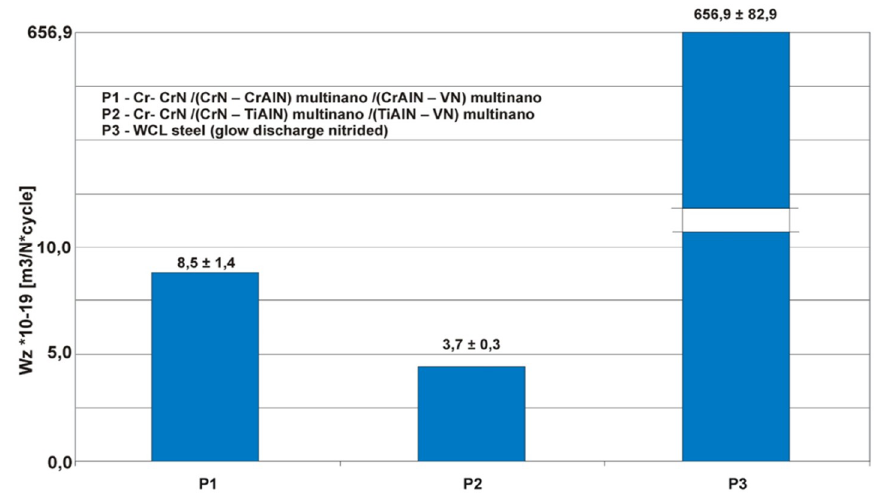
Figure 9. Wear resistance of P1, P2 multilayer coatings and reference nitrided tool steel.